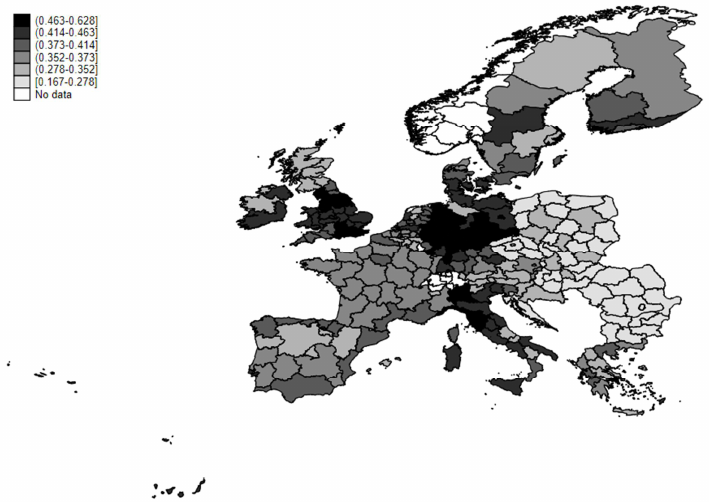
Figure 2. TFP of the EU regions